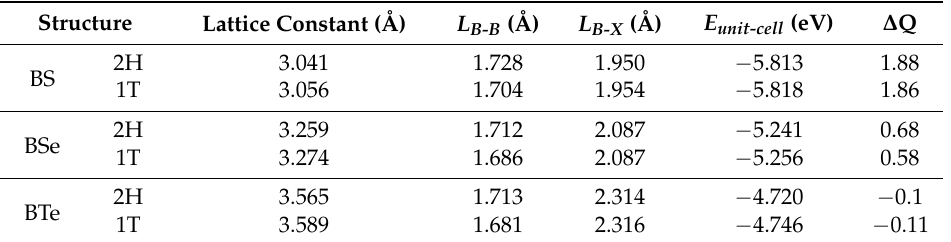
Figure 1. Top and side views of atomic configuration of single-layer BS with 2H and 1T lattices, with ABBA and ABBC stacking sequences, respectively. For the right side views the electron localization function 3D profiles are also plotted. The red box shows the unit-cell which includes four atoms. The VESTA [41] package was employed to illustrate the atomic structures. Table 1. Lattice parameters of energy minimized BX monolayers. Here, L B-B and L B-X , E unit-cell , and Δ Q stand for B-B and B-X bond lengths, energy per atom of a unit-cell, and Bader results for charge transfer from a single B atom to a chalcogen atom, respectively.